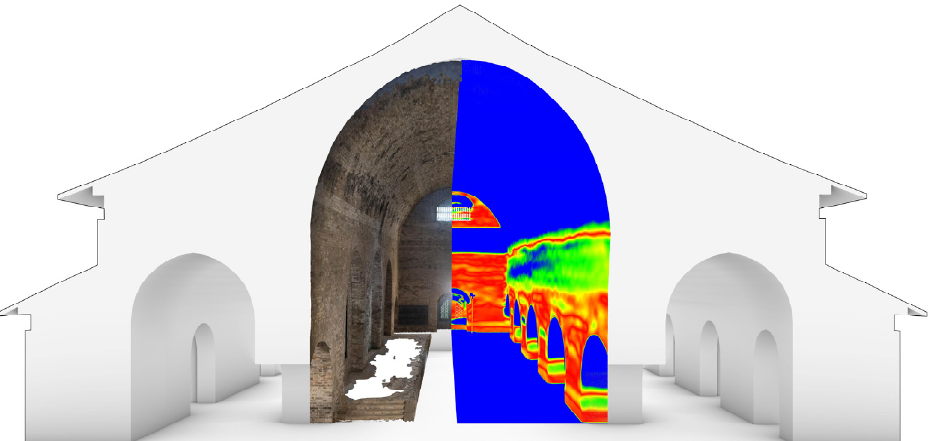
Figure 8. Visual expression of the deformation area of the south wall of CA (the true colour of CA in the figure is from photogrammetry, and the pseudocolour indicates the verticality of the wall).